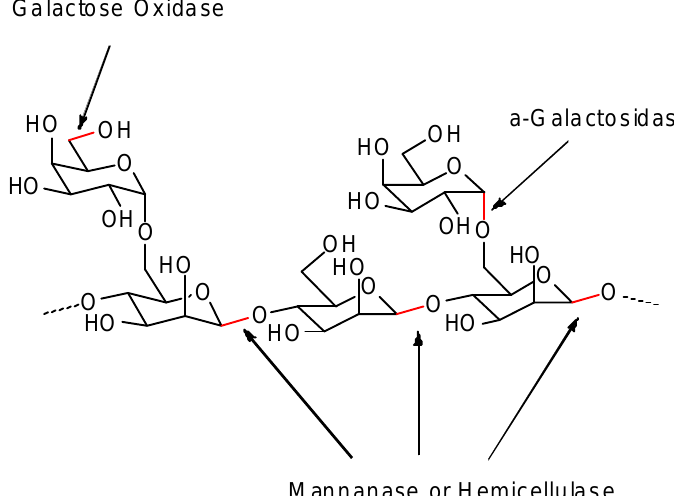
Figure 12. Structure of guar and bonds susceptible to